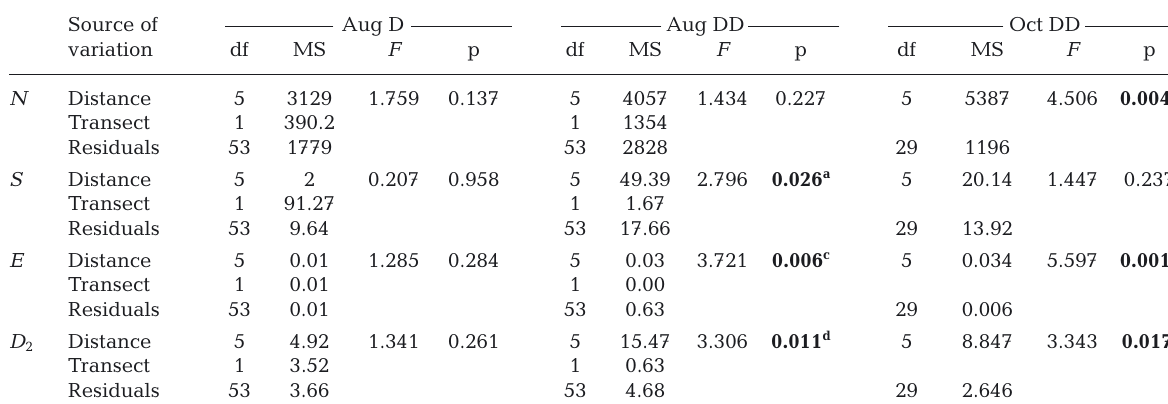
Table 4. Results of ANOVAs testing the effect of distance (−25, −10, 0, 10 and 25 m, and reference stations) on abundance ( N) , richness ( S) , evenness ( E) and Simpson’s inverse ( D 2 ) indices. D: standard density; DD: double density